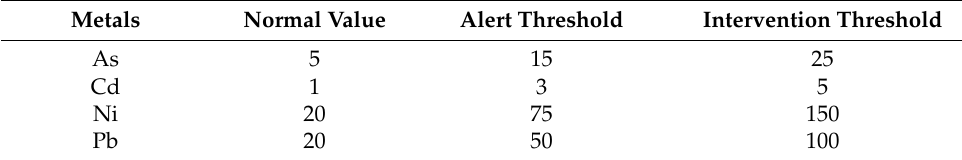
Table 2. Romanian reference values for soils with sensitive uses (mg kg − 1 d.w.)